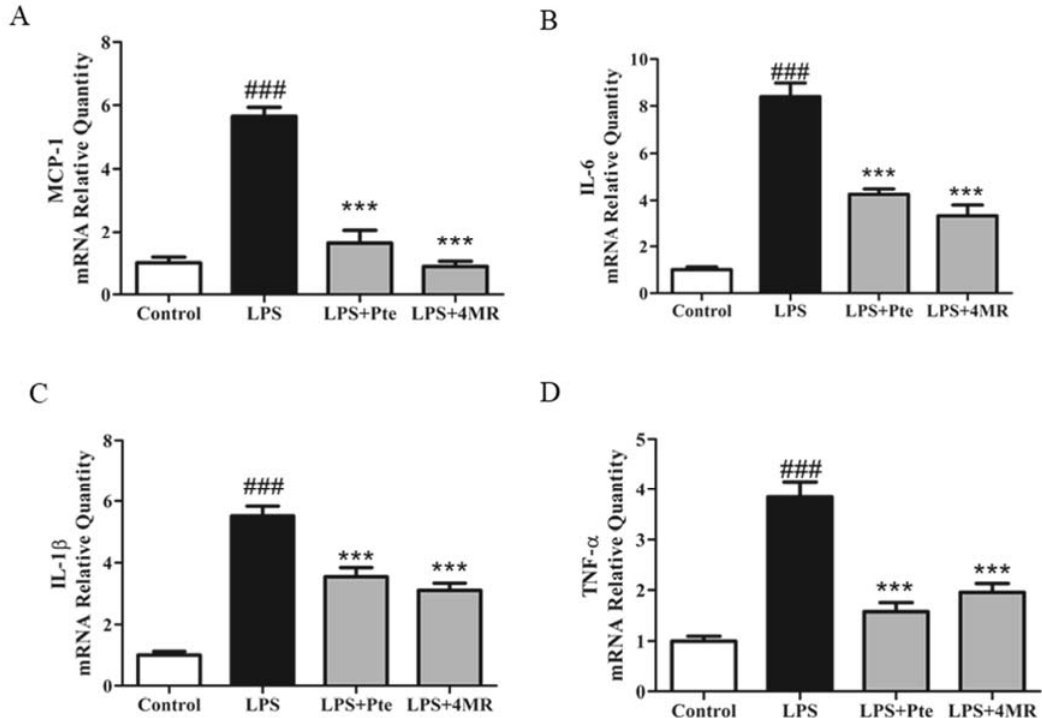
Figure 4. Effect of Pte and 4MR on LPS-induced proinflammatory cytokines expression in RAW264.7 cells. Cells were cotreated with both LPS (0.1 µ g/mL) and Pte (5 µ M) or 4MR (5 µ M) for 24 h. The mRNA expression levels of ( A ) MCP-1 ( B ) IL-6 ( C ) IL-1 β ( D ) TNF- α were evaluated by qRT-PCR and normalized to the 18S levels. The data were representatives of three independent experiments and presented as the mean ± SEM. ### p < 0.001 compared to control; *** p < 0.001 compared to LPS alone.